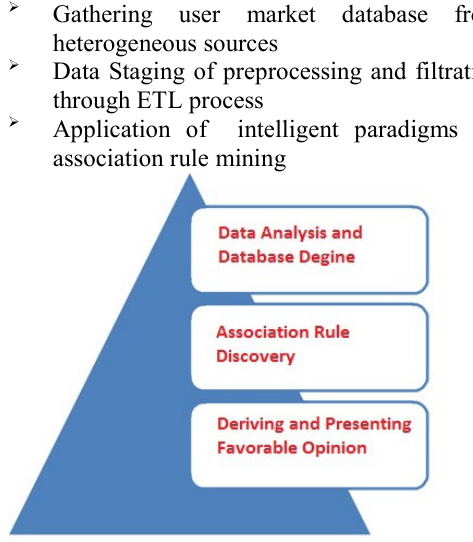
Figure 1: Proposed Knowledge